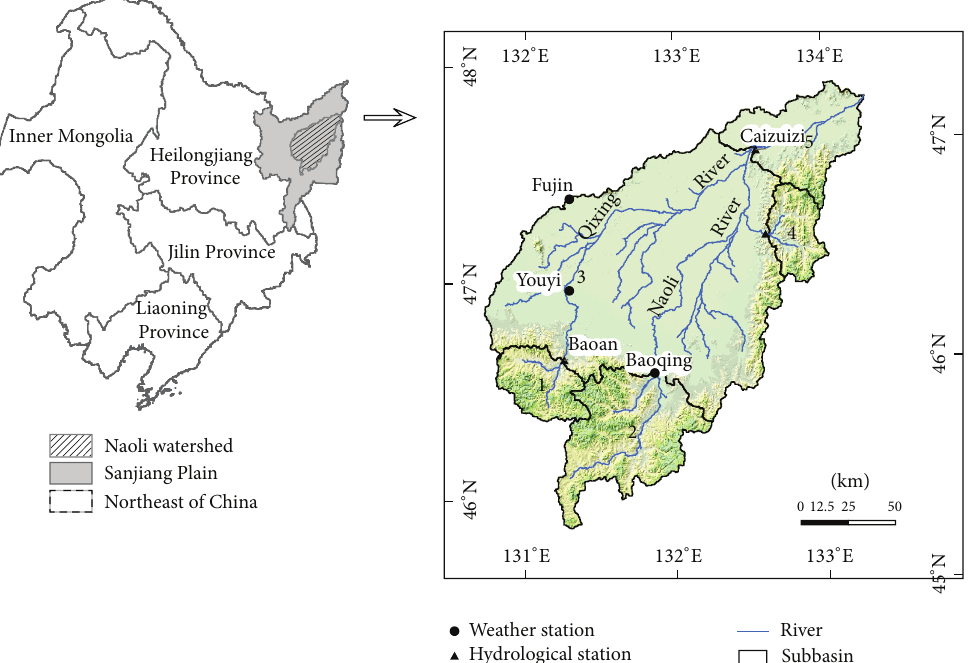
Figure 1: The location sketch of study